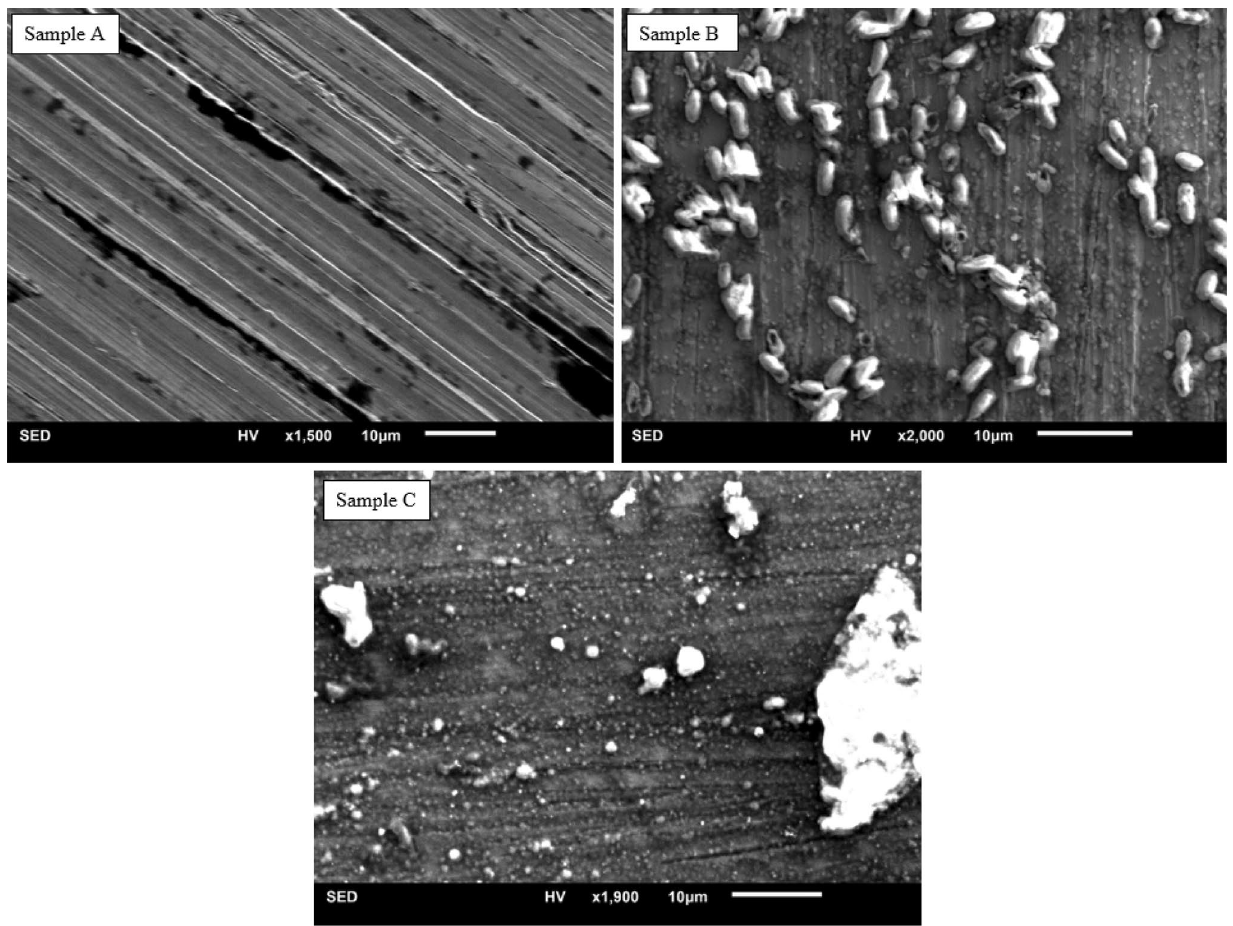
Figure 2. Scanning electron microscope (SEM) secondary electron detector (SED) image of test samples. Sample A, SED-SEM image of Sample A at × 1,500 magnification. Sample A represents the baseline sample, shielded from electromagnetic radiation and electrical oscillation, held in simulated synovial fluid (50/50% by weight deionized water and Millipore Sigma Fetal Bovine Serum). Sample A illustrates only minor surface change from the original polished surface. Sample B, SED-SEM image of Sample B at × 2,000 magnification. Sample B represents a corrosion sample subjected to a 50 MHz sine wave at 200 mVpp held in simulated synovial fluid. Sample B shows significant surface modification, marked by patterned oblong type surface growth. Sample C, SED-SEM image of Sample C at × 1,900 magnification. Sample C represents a corrosion sample subjected to a 25 MHz square wave at 200 mVpp held in simulated synovial fluid. The surface shows significant surface modification, marked by random